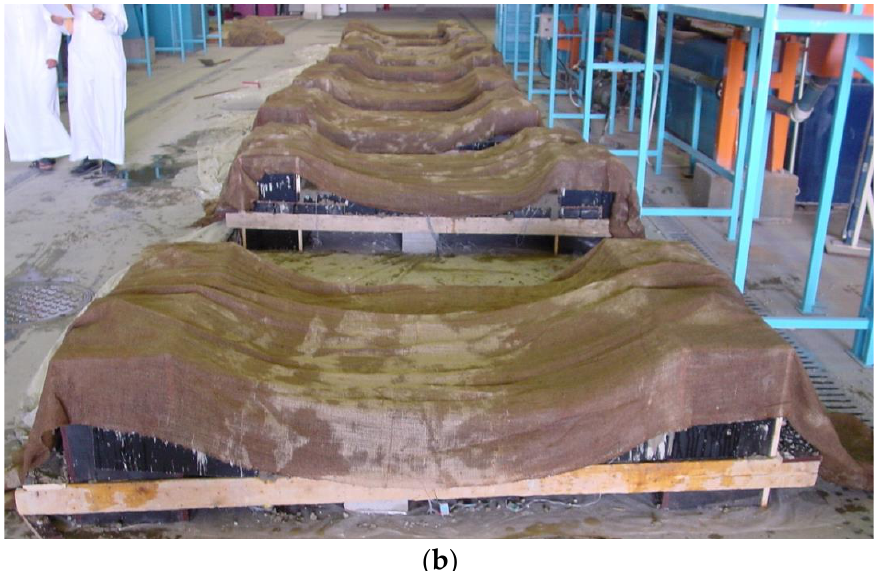
Figure 2. Casting of columns: ( a ) steel cage in wooden form ready for casting in horizontal position; ( b ) curing of column specimens.